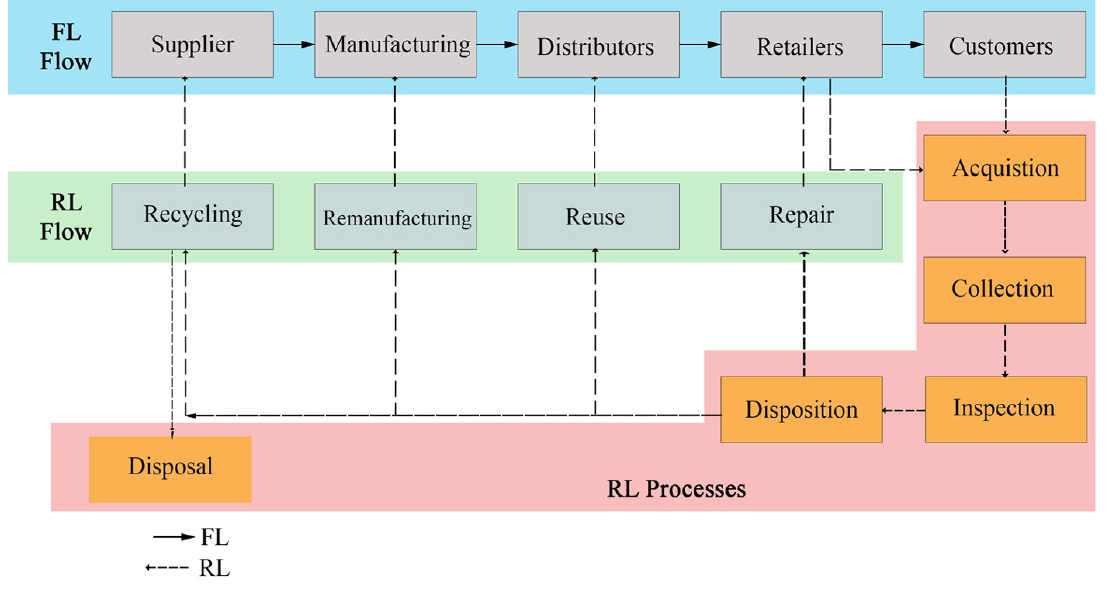
Figure 4. The flow of forward logistics (FL) and reverse logistics (RL) processes [9].